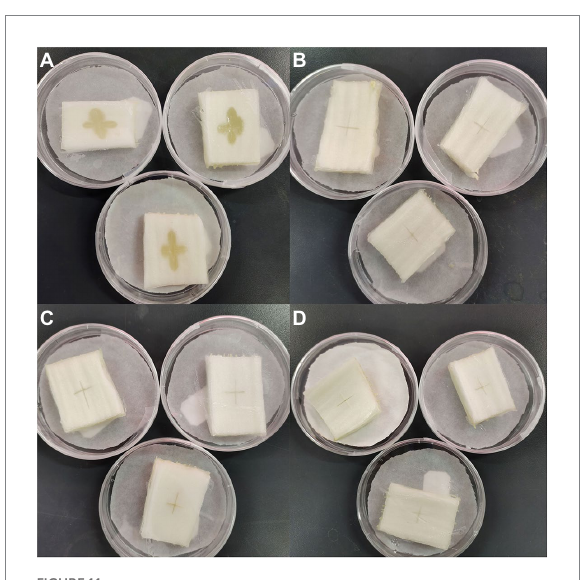
FIGURE 11 Results of in vitro experiments on the inhibitory effect of AgNPs in combination with zhongshengmycin on P. carotovorum . The panel (A) is the result of the control without being treated with AgNP or zhongshengmycin, while B–D are the results of explants treated with 10 μ g ml − 1 AgNP, 60 μ g ml − 1 zhongshengmycin, and the combined of 2 μ g ml − 1 + 5 μ g ml − 1